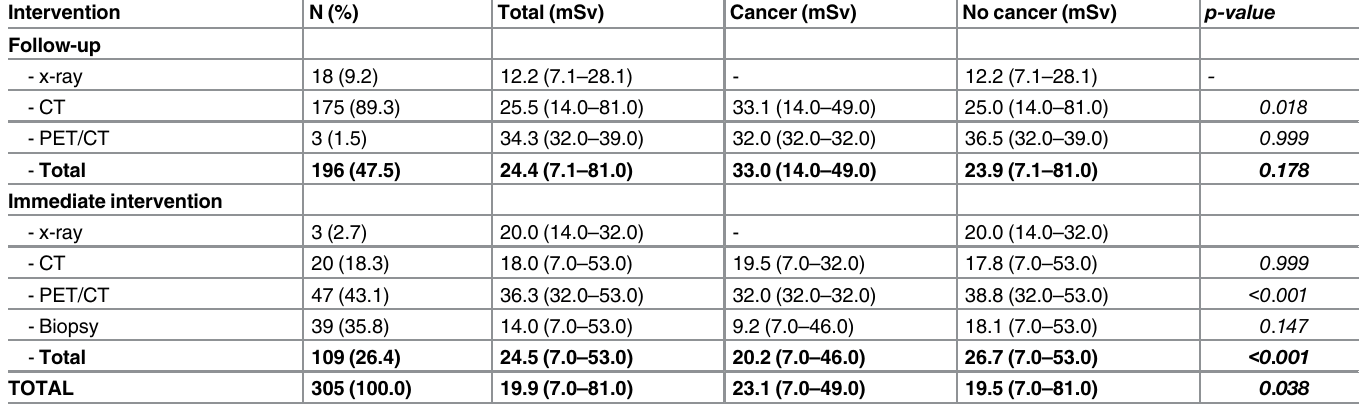
Table 5. Analysis of the radiation exposure (mean, minimum, maximum) associated with the management of SPN for CT according to the manage- ment strategy and for patients with a final diagnosis of lung cancer and those without it. Intervention